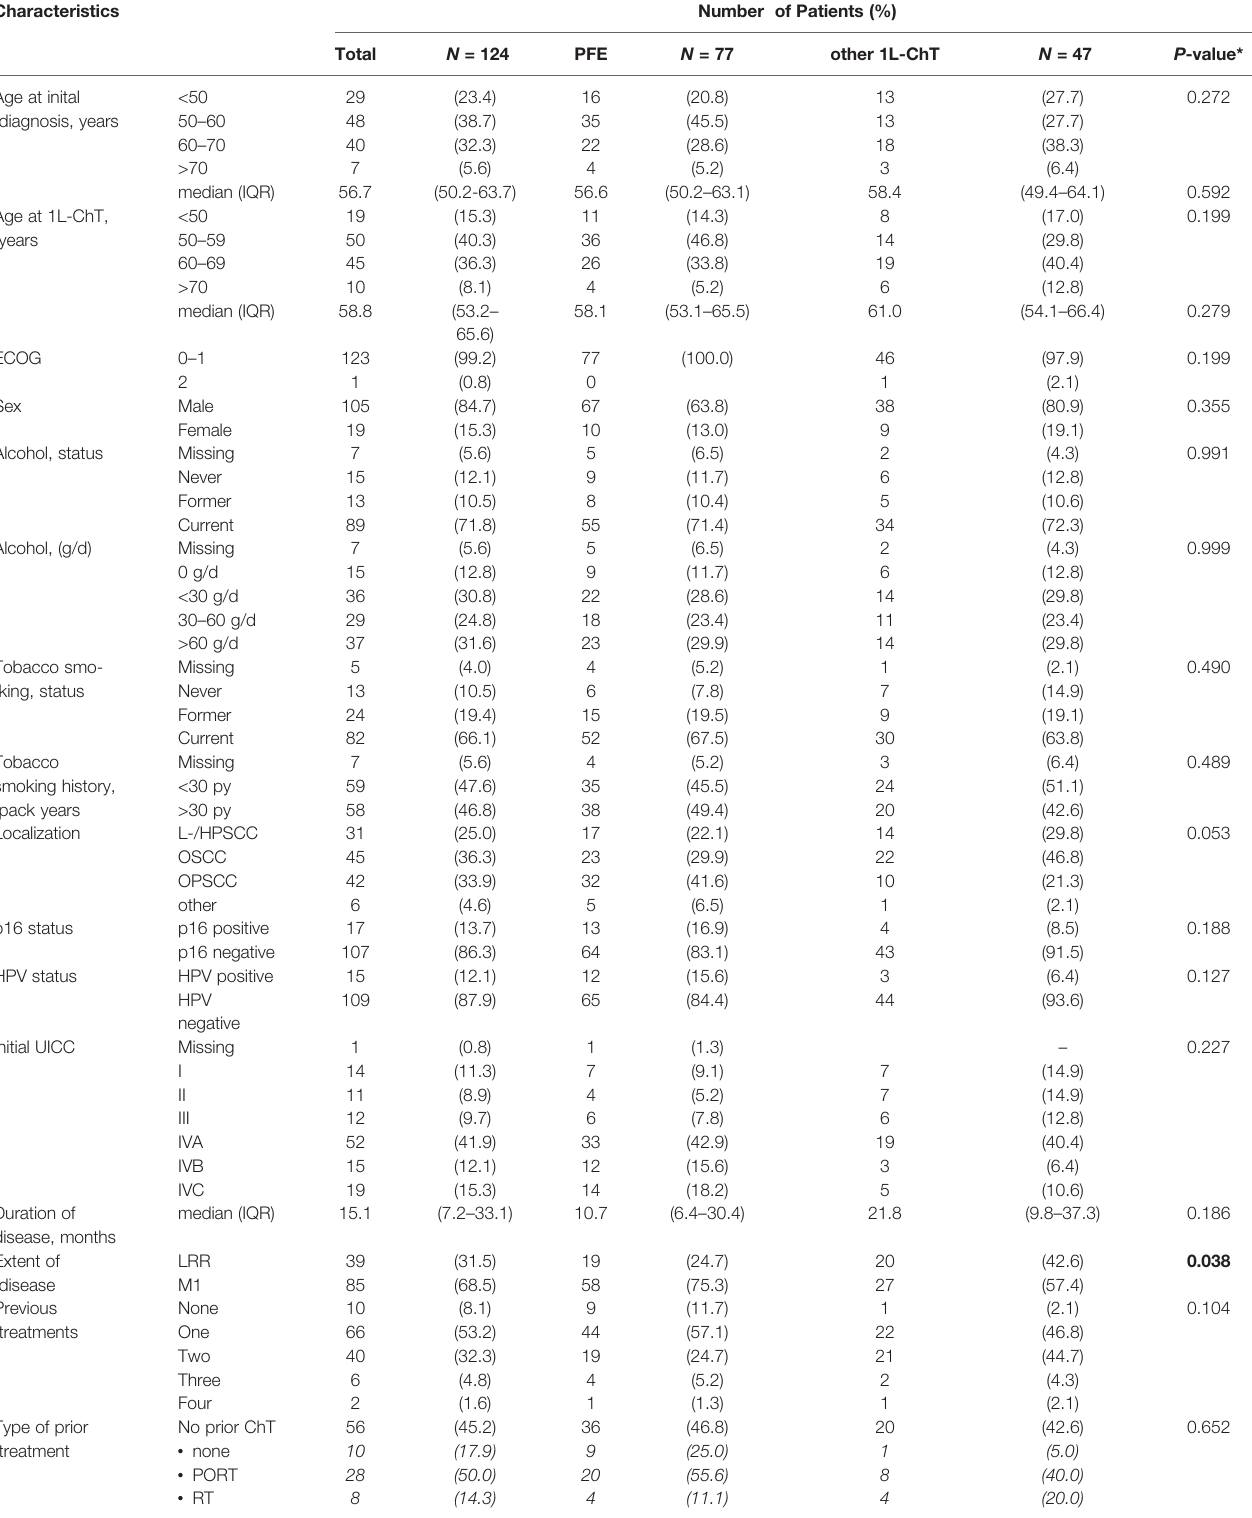
TABLE 1 | Clinical and epidemiological characteristics, diagnostic procedures and treatment as well as various survival measures for 5-years outcome of recurrent/ metastatic head and neck squamous cell carcinoma (R/M HNSCC) patients of the two subgroups, PFE and other 1L-ChT.